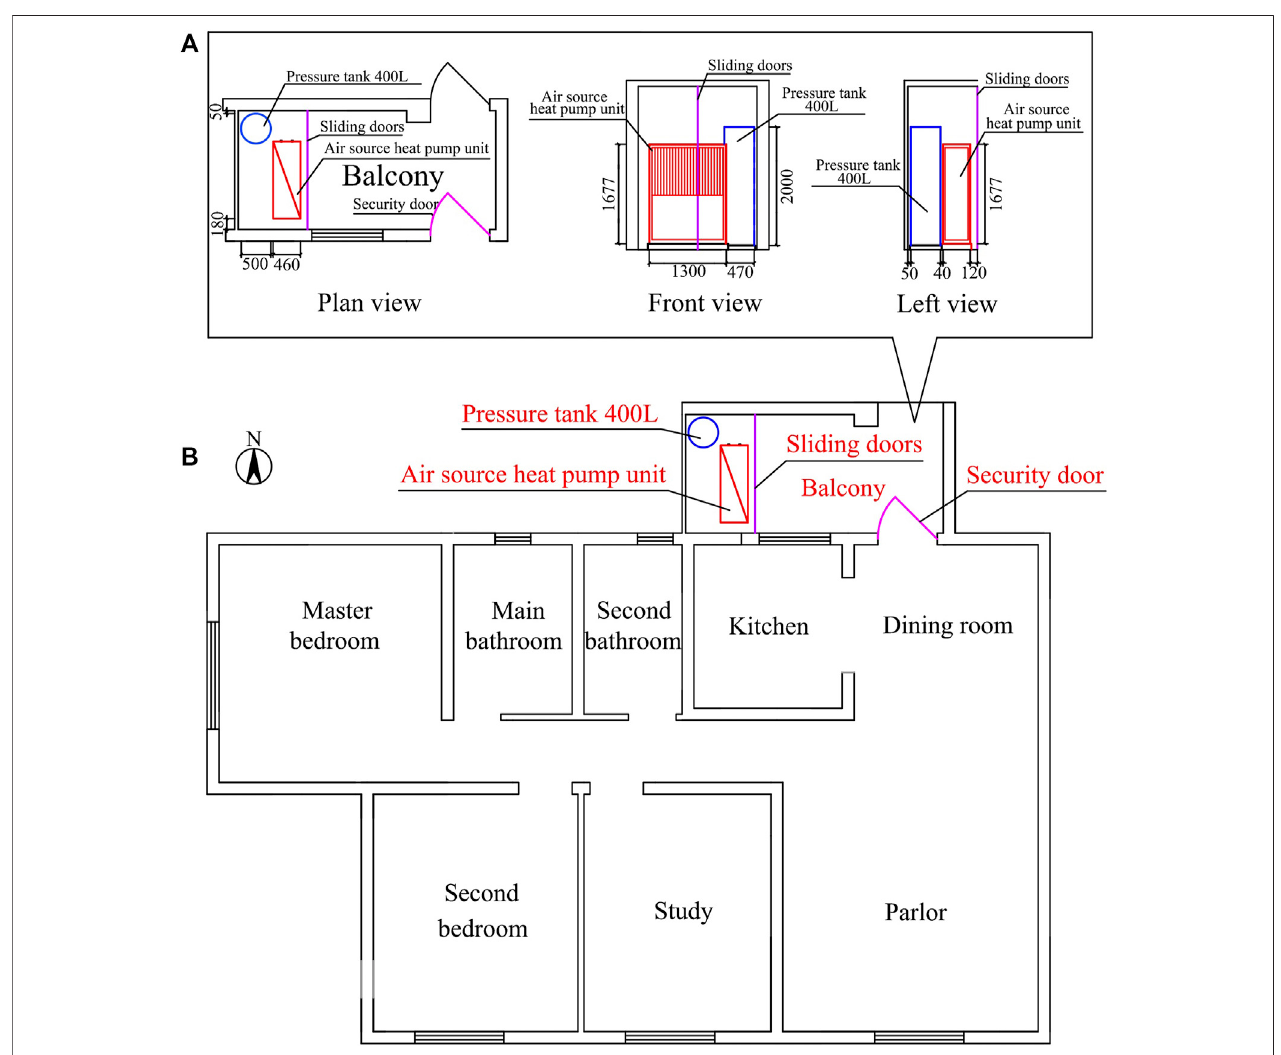
FIGURE 3 | The user plan and outdoor unit installation position in the